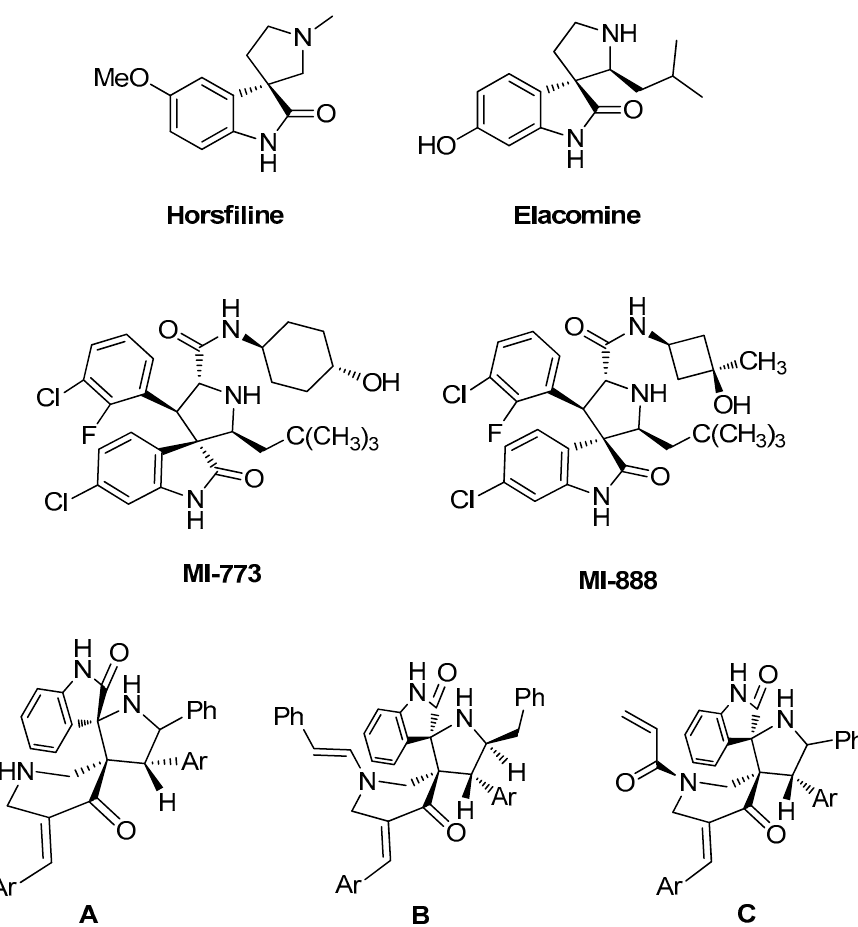
Figure 1. Representative natural and unnatural spirooxindole–pyrrolidine heterocyclic hybrids. ( A ) The spirooxindole–pyrrolidine heterocyclic hybrids, ( B ) The N-styryl-substituted spirooxindole–pyrrolidine heterocyclic hybrids, ( C ) The N-acrolyl derivatives.